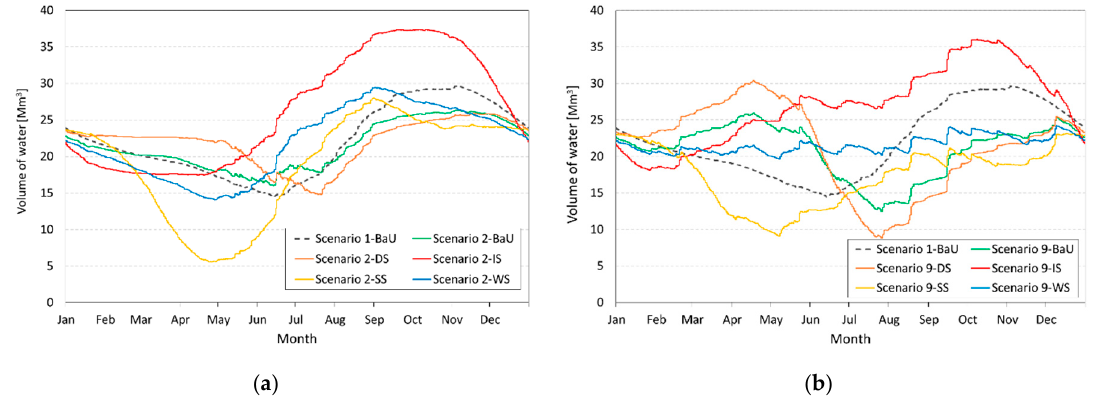
Figure 9. Evolution of the reservoir’s volumes with a 95% confidence interval at 2030 for mixed scenarios. ( a ) Climate scenario 2 with all price scenarios and ( b ) climate scenario 9 with all price scenarios.